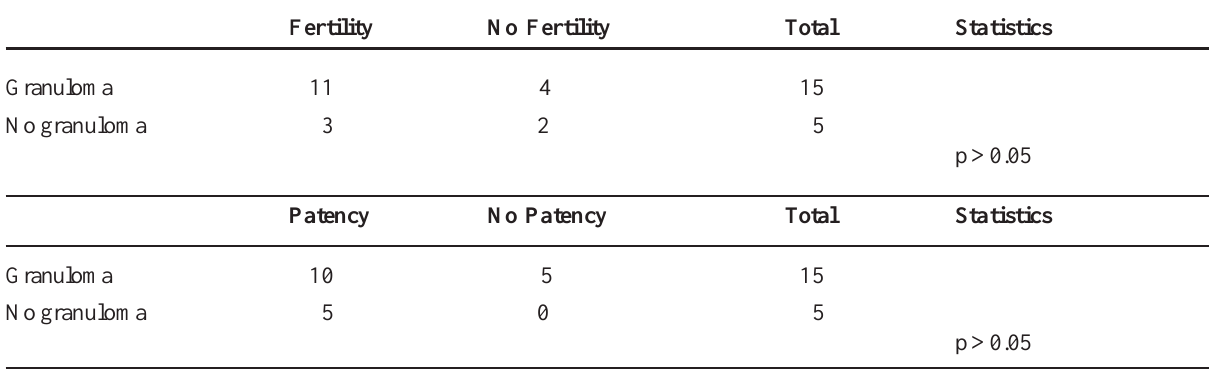
Table 1 – Comparison between spermatic granuloma in vasovasostomy site and fertility rates in vasovasostomy with microsuture.